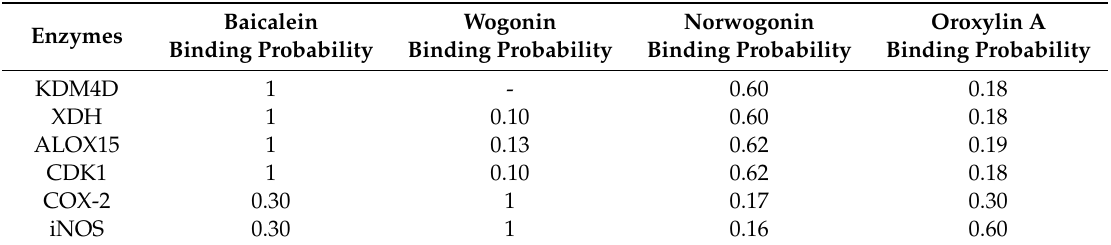
Table 6. The human proteins included in respiratory disorders as targets for baicalein, baicalin, wogonin, norwogonin, and oroxylin A and their binding probability.